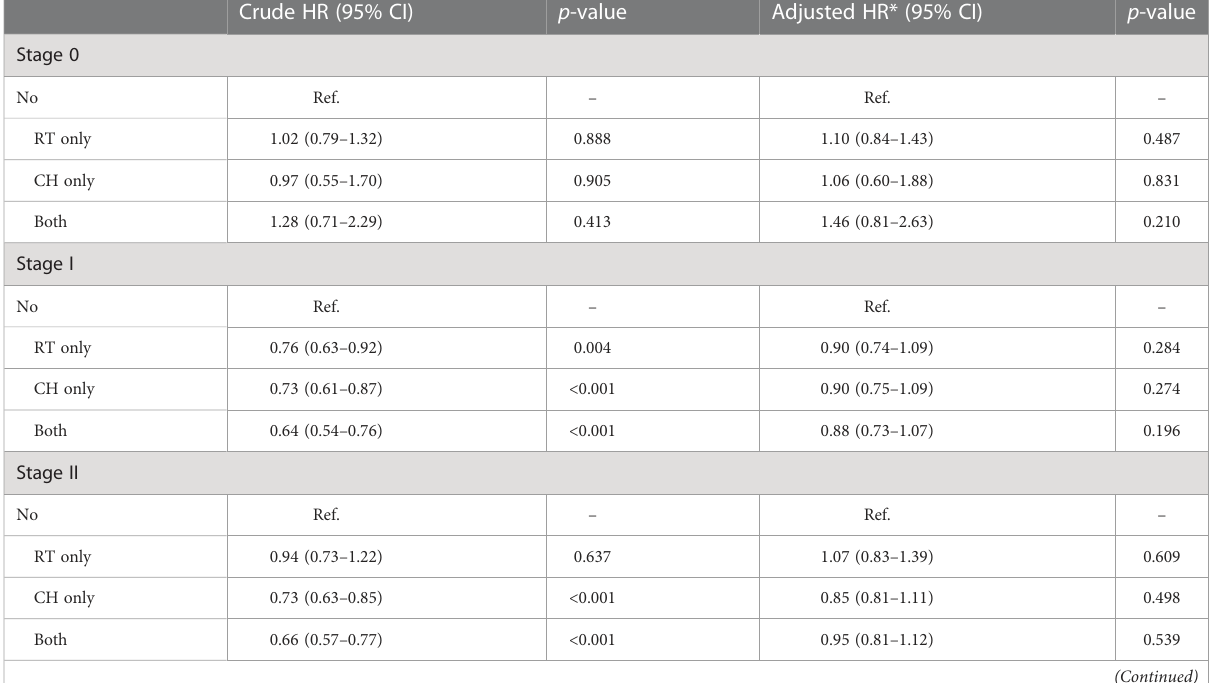
TABLE 5 Crude and adjusted hazard ratios of radiotherapy and chemotherapy for second primary malignancies in different